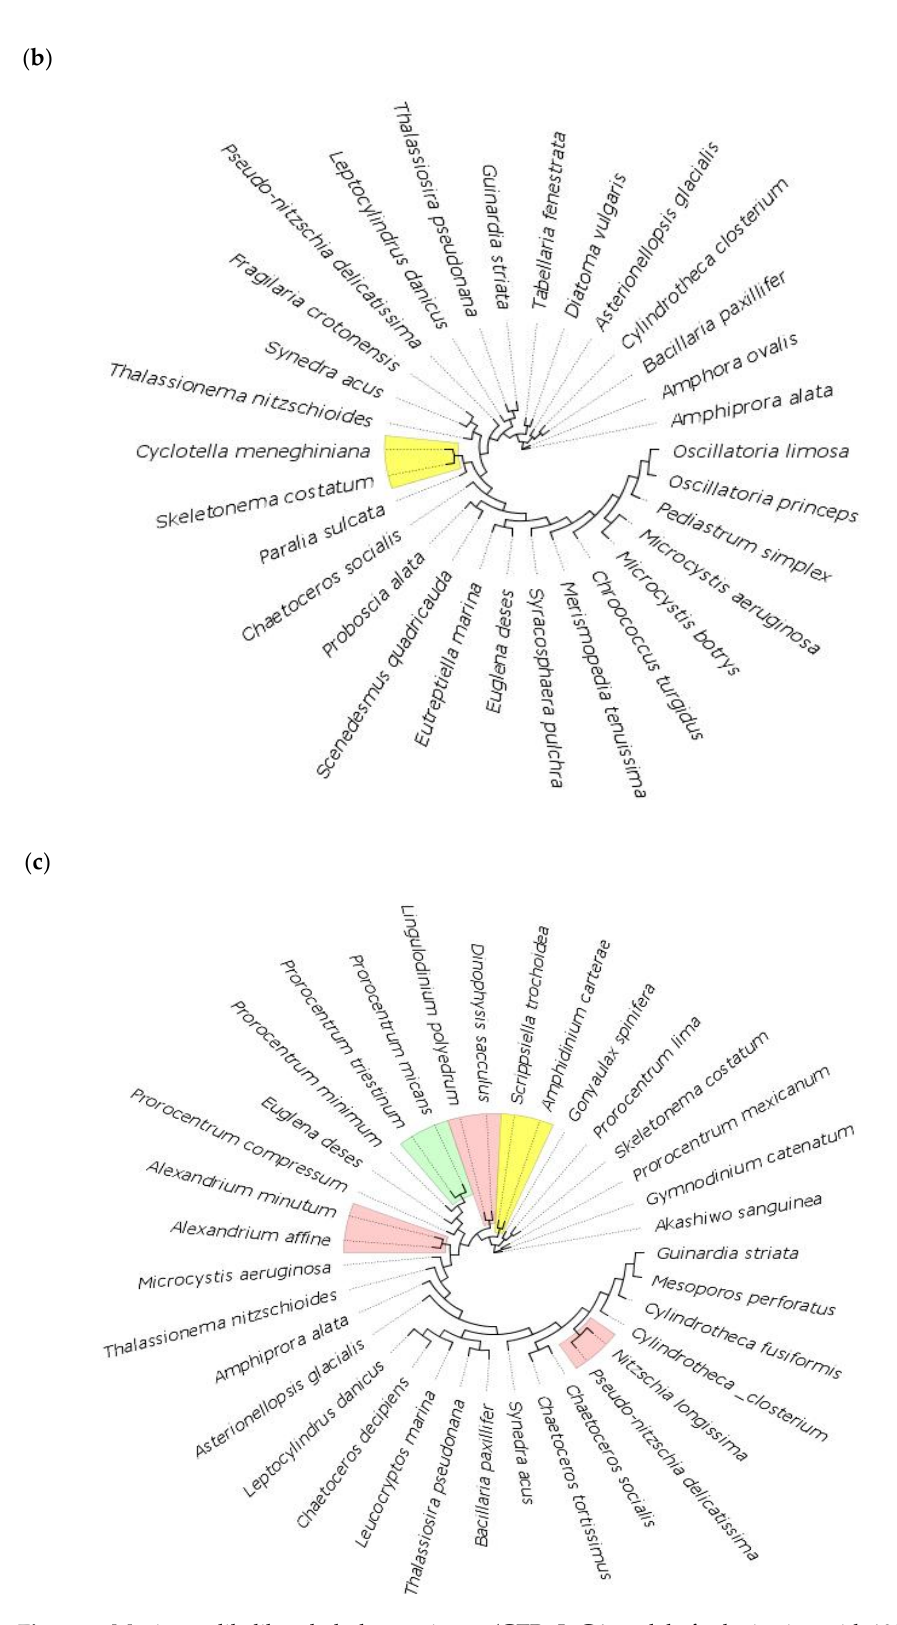
Figure 5. Maximum likelihood phylogenetic tree (GTR+I+G4 model of substitution with 100 bootstrap replicates) of transitional water species for 18S marker ( a ), 16S marker ( b ) and COI marker ( c ). Colored branches indicate species that cluster together under bPTP analysis, with green representing Bayesian support (BS) values of 0.3 or below, yellow for BS 0.3–0.5, red for BS